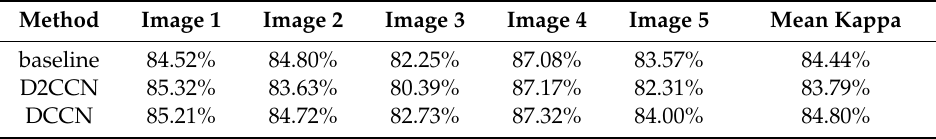
Table 8. The kappa coe ffi cient results of the baseline, D2CCN, and DCCN.